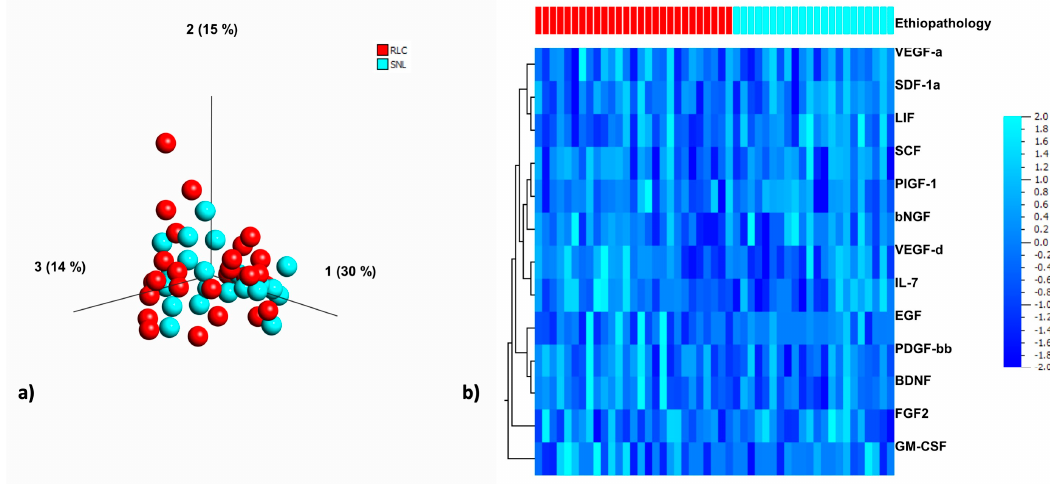
Figure 3. PCA of the growth factor microenvironment in livers of BA patients and clustered heat map for visualization and interpretation of the individual growth factor profile. Legend: ( a ) The scatterplot depicts a PCA of growth factors in BA patients with rapid liver failure (red) versus long term survival (blue). In this three-dimensional visualization, the blots distribute evenly without any grouping. Therefore, the variation in the expression of growth factors in the livers of BA patients at the time of KPE does not appear to be related to prognosis. ( b ) The heat-map visualizes the data with a grid matrix. The columns represent each patient/liver sample (red = rapid liver failure; blue = long term survival with native liver) and the rows represent each growth factor/chemokine. Intensity of the blue color visualizes changes of GF expression. No correlation was identified in the clustering. Table 5. Log transformed data analysis of all growth factors/chemokines in liver tissue.